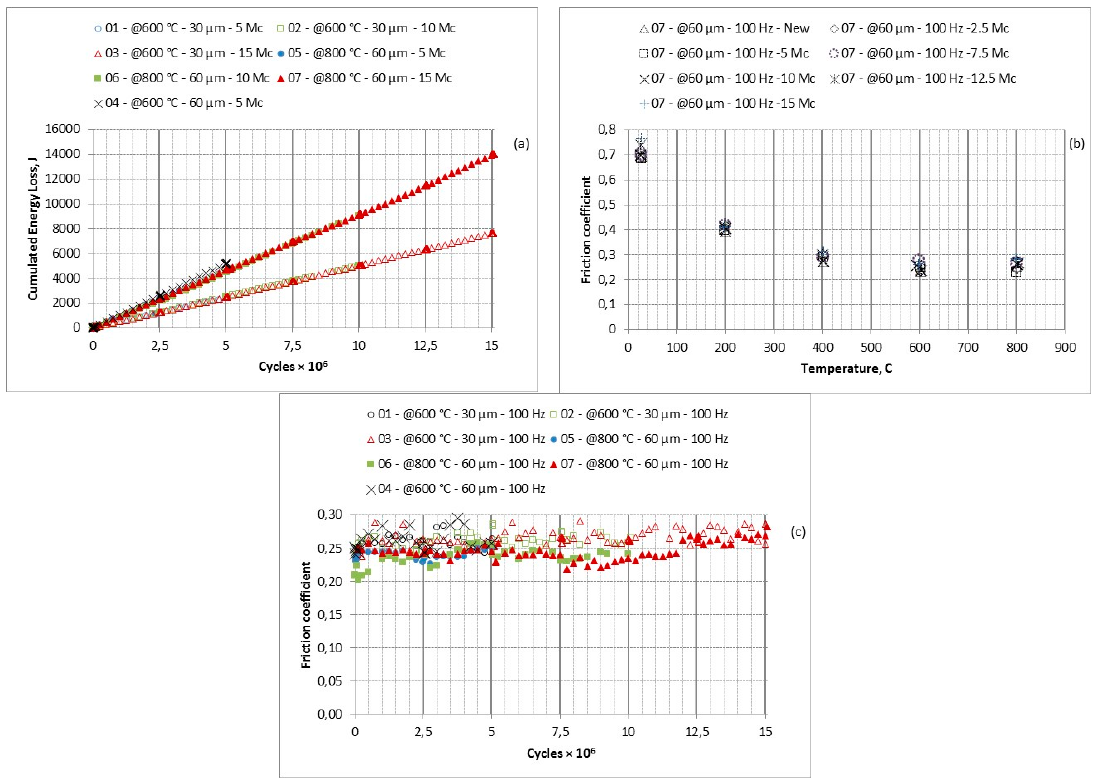
Figure 6. ( a ) Cumulated energy loss; ( b ) friction coefficient as a function of temperature of the pair 07; ( c ) friction coefficient as a function of wear cycles at 100 Hz.